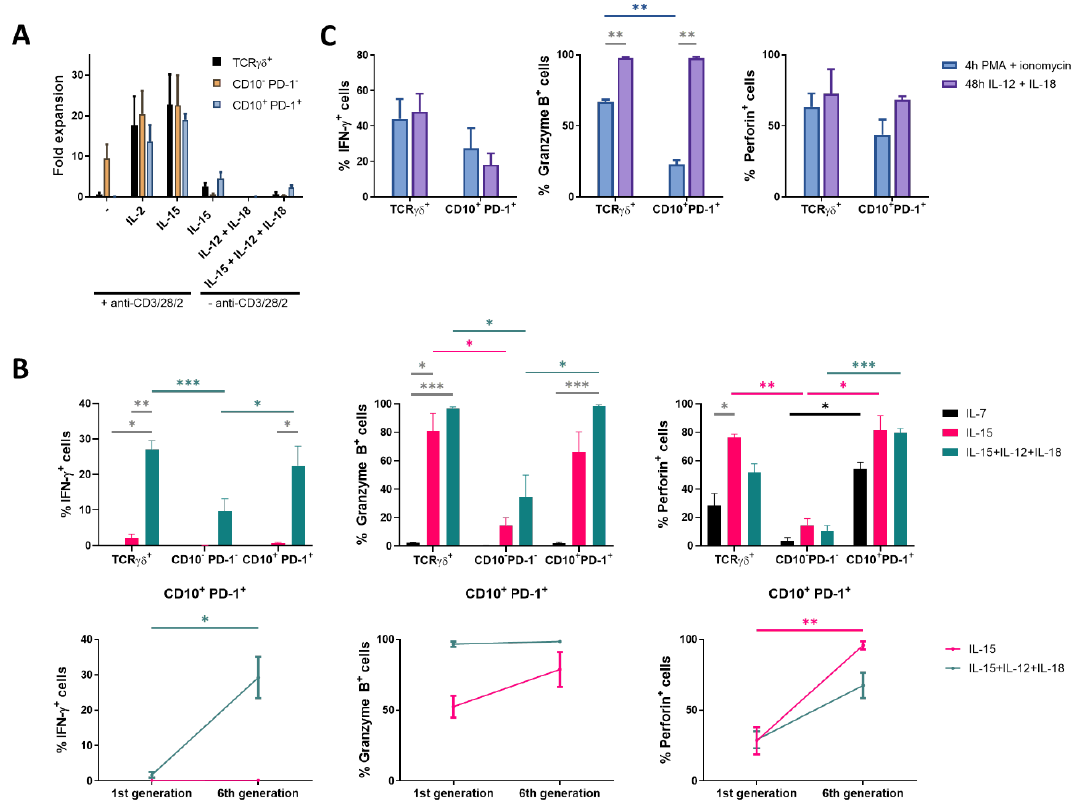
Figure 3. Proliferation with IL-15 induces cytotoxic mediators in CD10 + PD-1 + IELps. ( A ) fold expansion of TCR γδ + , conventional and IELp cells cultured for 8 days under various conditions (n = 2); ( B ) IFN- γ , granzyme B and perforin production by unstimulated TCR γδ + , conventional and IELp cells incubated for 5 days in the presence of IL-7, IL-15 or IL-15 + IL-12 + IL-18. IFN- γ , granzyme B, and perforin production measured via intracellular flow cytometry. Bottom: Cytokine production in IELps, plotted for the first and sixth / last generation (Figure S5; mean ± SEM, n = 3); ( C ) flow cytometric analysis of IFN- γ , granzyme B and perforin production by TCR γδ + cells and IELps proliferated for 6 days with IL-15, followed by stimulation with IL-12 + IL-18 for 48 h or with PMA + ionomycin for 4 h (mean ± SEM, n = 3). Dunnett’s multiple comparisons test was used to assess statistically significant di ff erences in cytokine production between the di ff erent populations and di ff erent interleukins. p -value < 0.05 (*), p < 0.01 (**), and p < 0.001 (***).